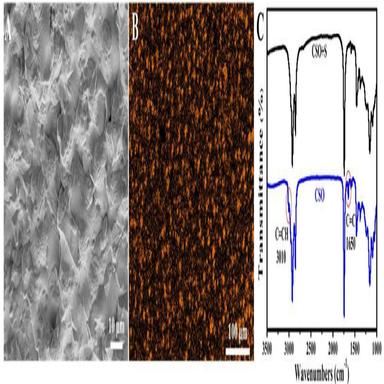
(A) SEM image, (B) S element mapping, (C) FT-IR spectra of polysulfide. FT-IR, Fourier transform-infrared; SEM, scanning electron microscopy.